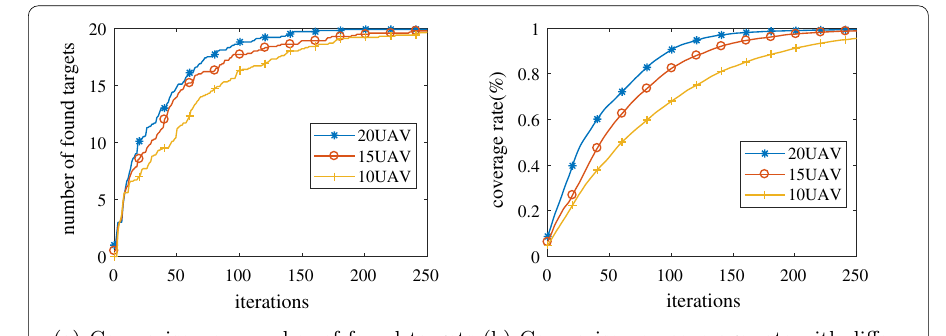
(a) Comparison on number of found targets with different number of UAVS. Fig. 7 Comparison after 250 iterations for the mission with HL-APF